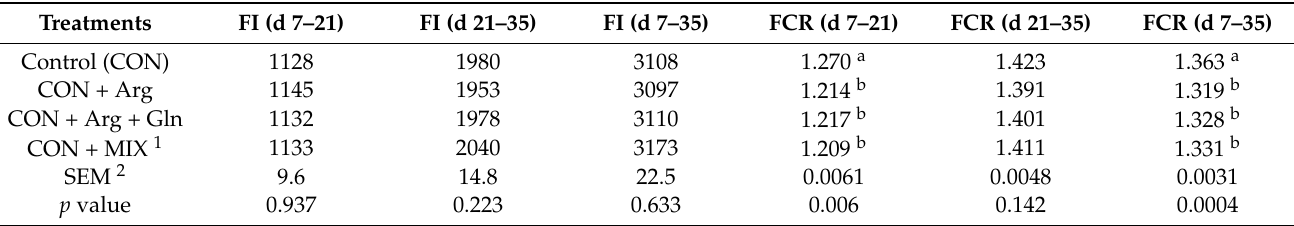
Table 4. Feed intake (FI, g/bird) and feed conversion ratio (FCR, g feed/g weight gain) of broiler chickens fed experimental diets (experiment